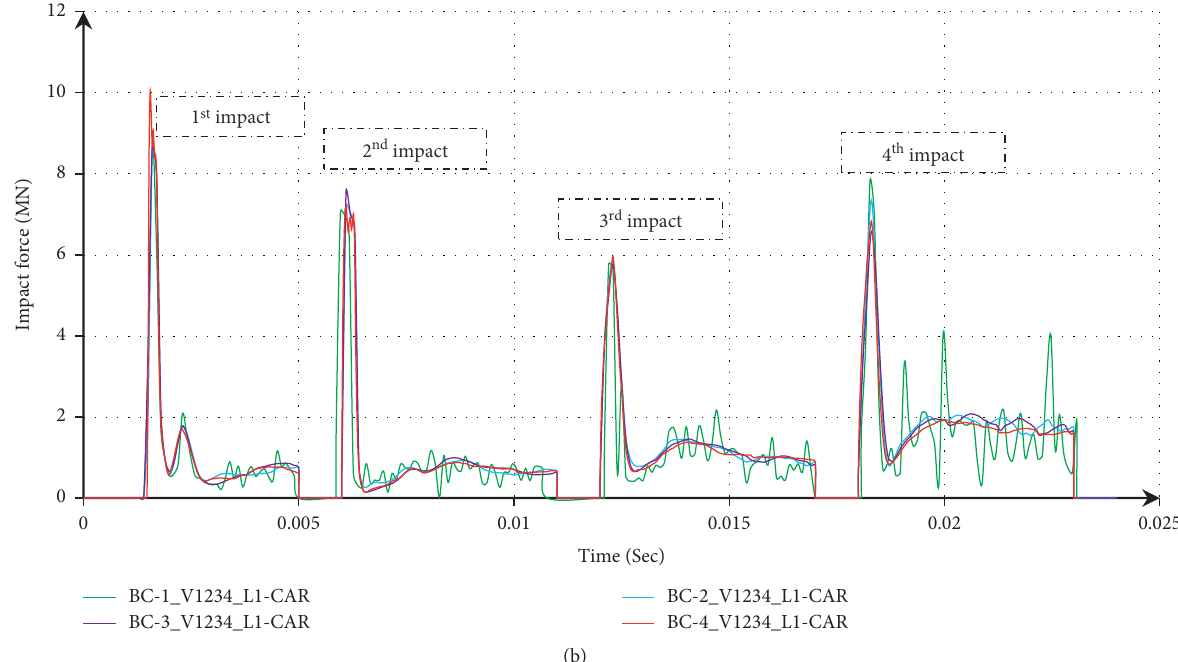
Figure 12: Effect of initial velocity on impact behavior of BRC column. (a) Under single impact load. (b) Under repeated impact load.